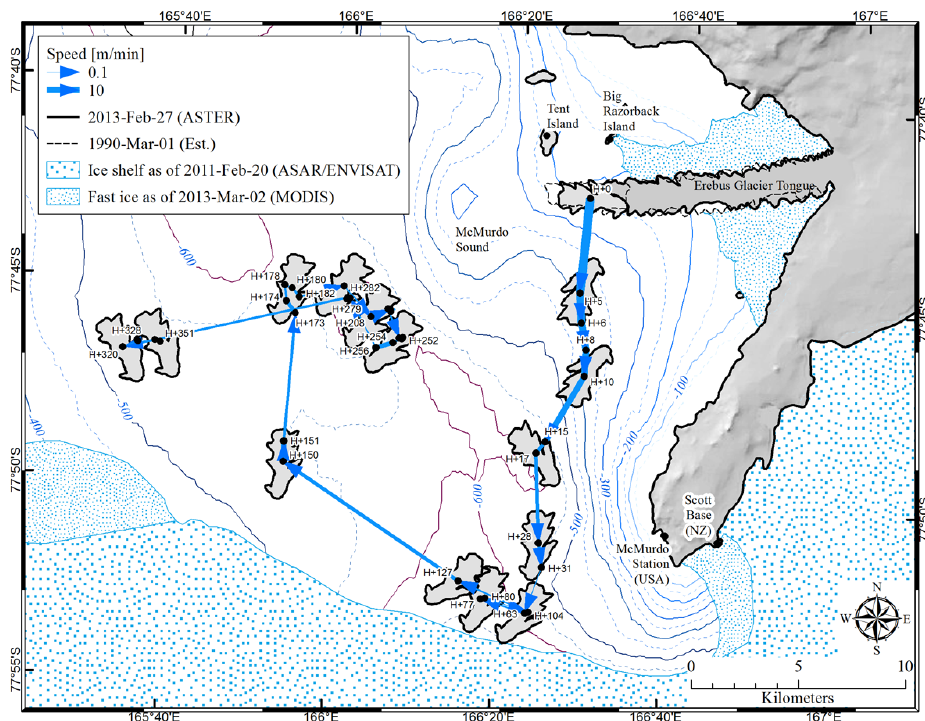
Fig. 3. EGT tip iceberg trajectory built from a sequence of 38 MODIS and 2 ASTER images from year day 57 (26 February 203) through to year day 80 (21 March 2013). Estimated time in hours since detachment is indicated at each location. The width of the arrow is indicative of the speed. Note the 180°rotation when passing McMurdo Station (H + 10 to H +